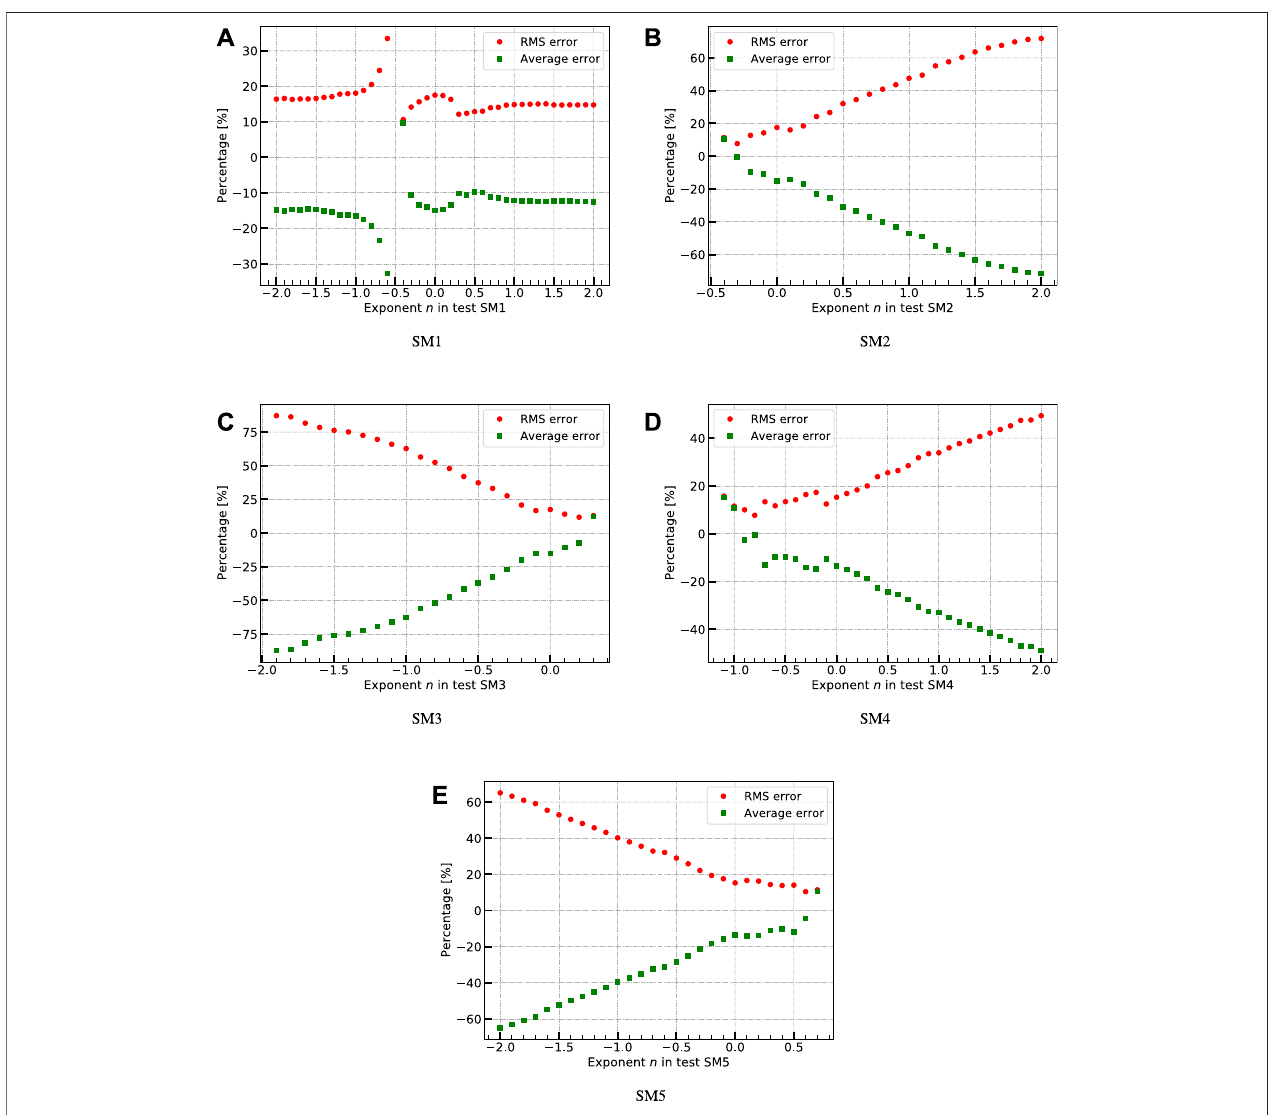
FIGURE 5 | Optimization results of each form of the scaling methods.